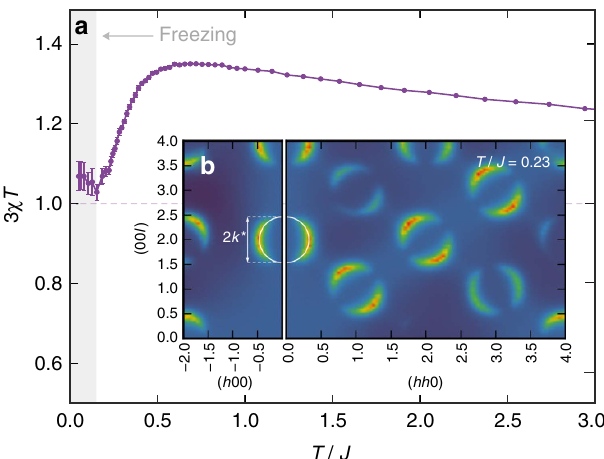
Figure 4 | Magnetic properties of extended spin ice. ( a ) Finite temperature susceptibility w of the spin slush model for a system of 10 3 cubic cells. The susceptibility passes through maximum near T B 0.6 J before settling into a Curie-like regime with 3 w T B 1. Freezing becomes apparent below T B 0.15 J , with the susceptibility depending on the detailed spin configuration of the frozen state. ( b ) Transverse moment–moment correlation function I ( k ) defined in equation (9), for the spin slush model at T ¼ 0.23 J for a system of 24 3 cubic cells. Cuts in the [ hhl ] and [ h 0 l ] planes are shown. Correlations are peaked on spherical surfaces of radius k * B 0.5(2 p / a ) where a is the size of a cubic unit cell. These spheres are centred on the locations of the pinch-points in spin